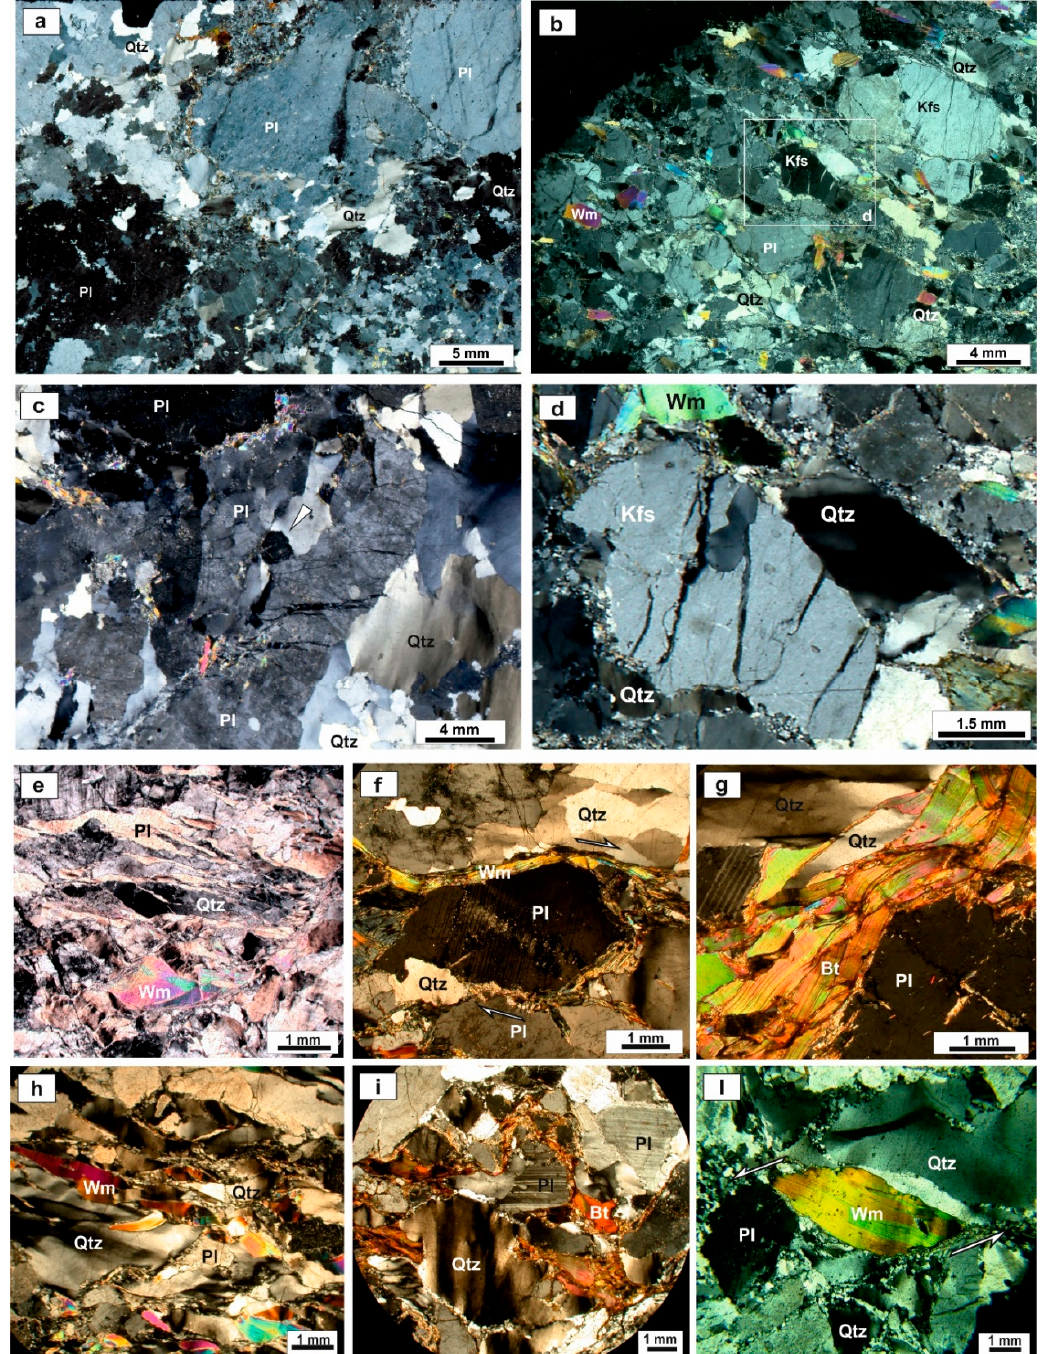
Figure 6. Shear-related microstructures in studied trondhjemites ( a , c , e , f , g ) and low-Ca granitoids ( b , d , h , i , l ) (crossed polars) Abbreviations: Pl, plagioclase; Qtz, quartz; Kfs, K-feldspar; Wm, white mica; Bt, biotite. ( a ) Protomylonitic texture in trondhjemite sample; ( b ) protomylonite texture in granite sample; ( c ) magnification of Figure 4a, illustrating a submagmatic fracture in plagioclase from a trondhjemite sample. The arrow indicates a euhedral plagioclase crystal caught in the narrowing part of the fracture; see the following text for more details; ( d ) magnification of figure b illustrating a set of submagmatic fractures in K-feldspar filled by quartz; it is possible to observe that the quartz in the two fractures from the right portion of the feldspar crystal is continuous with the quartz outside the feldspar; see the following text for more details; ( e ) preferred orientation of quartz ribbon, plagioclase and muscovite fish-like crystals defining an incipient foliation; ( f ) asymmetrically anastomosing Bt/Ms folia and σ -type plagioclase porphyroclast indicating a dextral shear-sense; ( g ) micaceous layer and elongated quartz grains defining a foliation deflected around a plagioclase